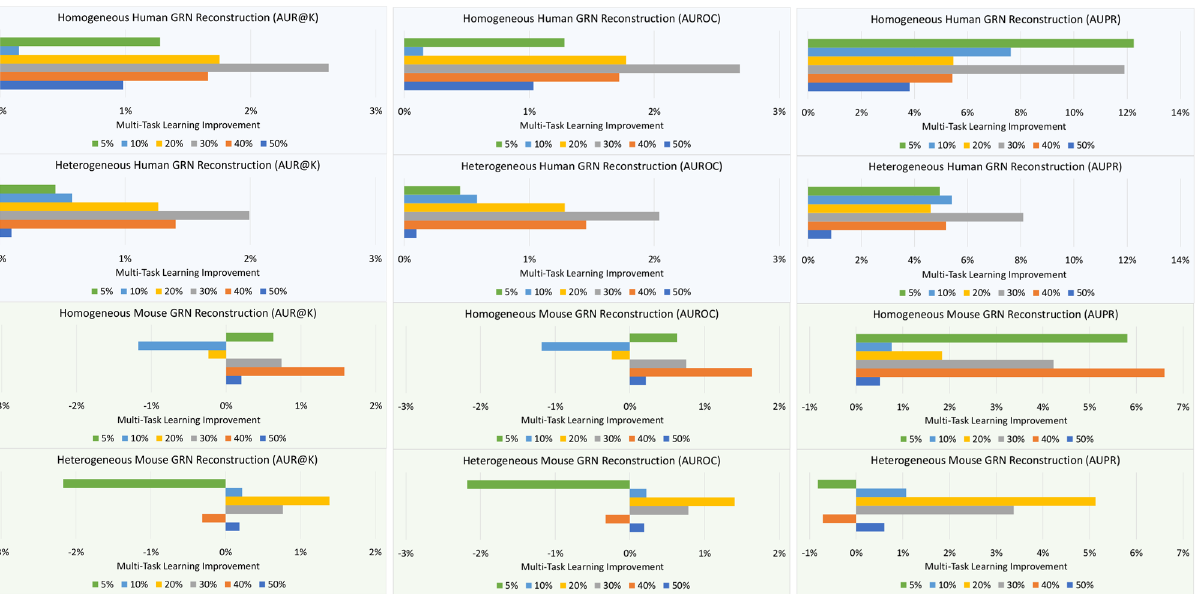
Figure 6. Improvement achieved by our approach with respect to no_transfer, in terms of AUR@K, AUROC and